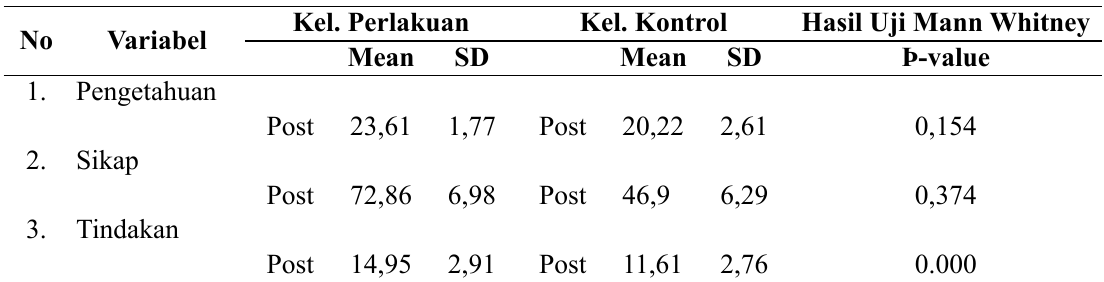
Tabel 4. Pengaruh Pemberdayaan Pasien Berbasis Experiential Learning terhadap kadar glukosa